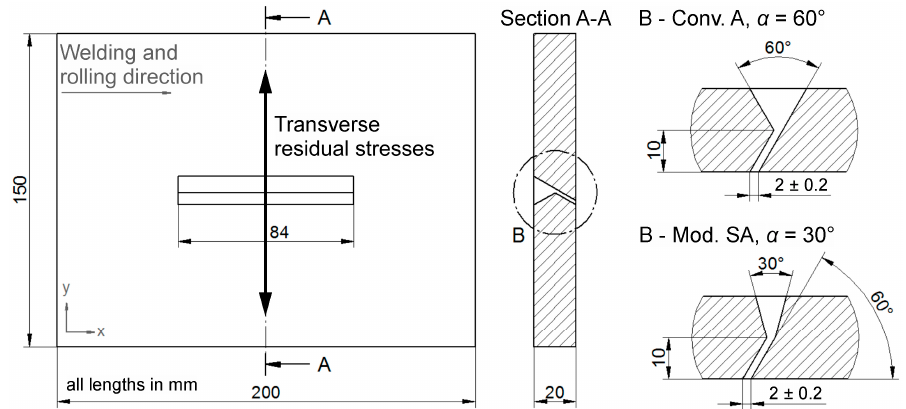
Figure 2. Geometry of the TEKKEN samples with two different weld seam configurations.